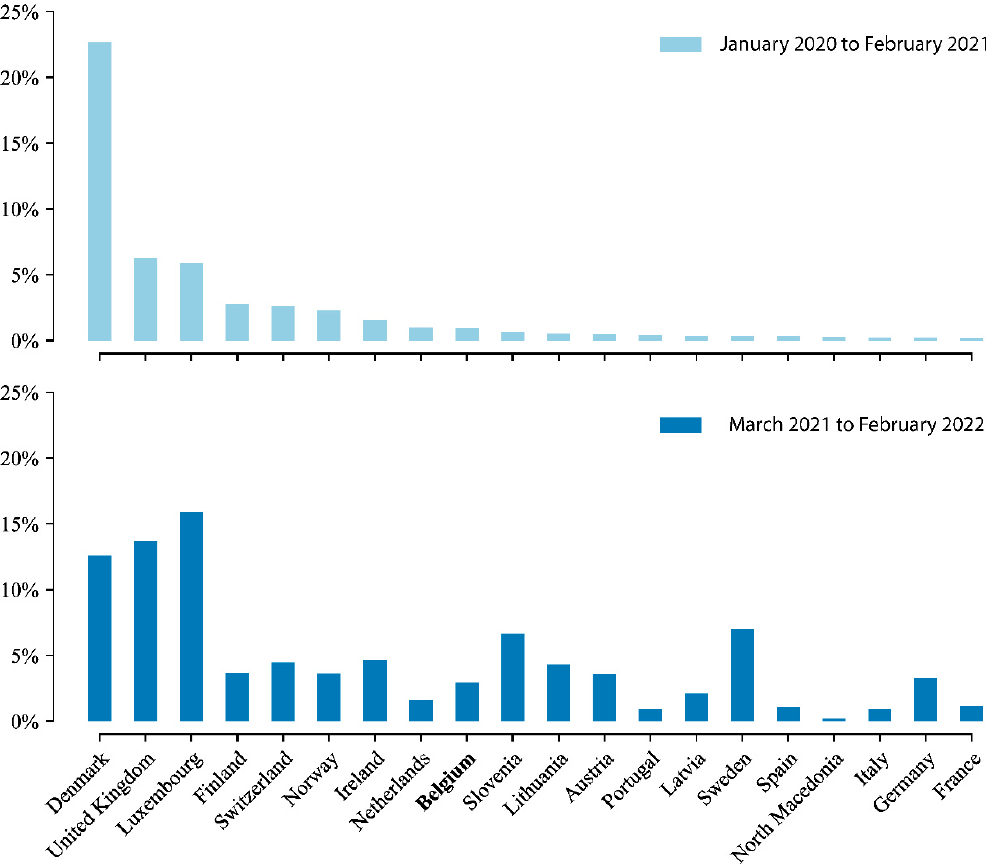
Figure 4. Sequencing efforts for European countries that reported over 10,000 positive cases on a given year, expressed as the percentage of confirmed COVID-19 cases sequenced that have been submitted to GISAID (retrieved from the GISAID database on 31 August 2022), with a minimum sequence/case ratio of 0.1%. Top: Sequencing coverage of positive cases prior to the establishment of the COVID-19 Genomics Belgian Consortium, from January 2020 to the end of February 2021. Bottom: Sequencing coverage of positive cases a year after the establishment of the consortium, from 1 March 2021 to the end of February 2022. Large discrepancies can be seen among European countries, both before and after March 2021, with Belgium’s performance in 2021 at a similar level as most of its neighboring countries.